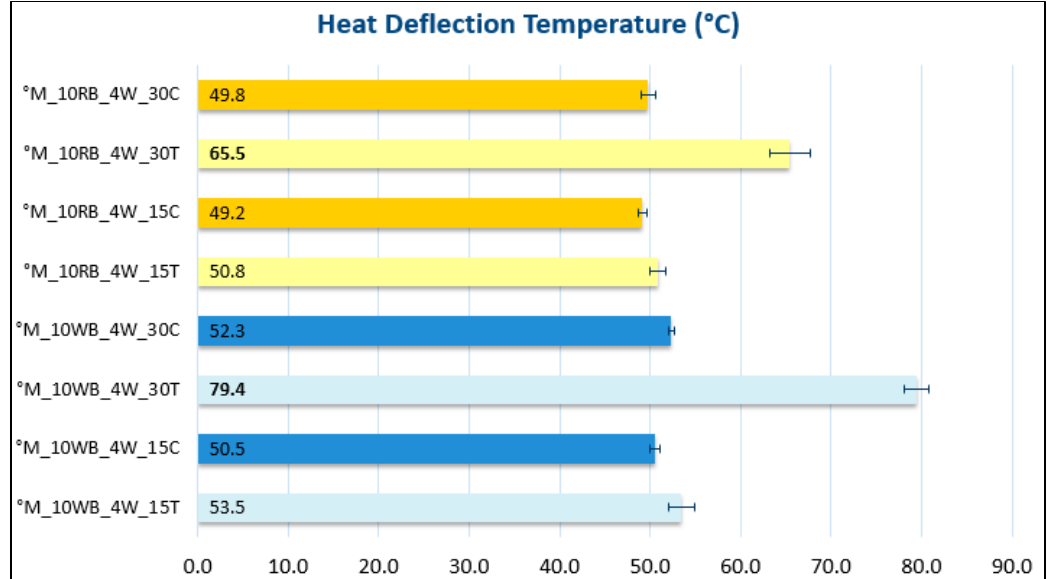
Figure 7. HDT measurements of inorganic filled biocomposites.